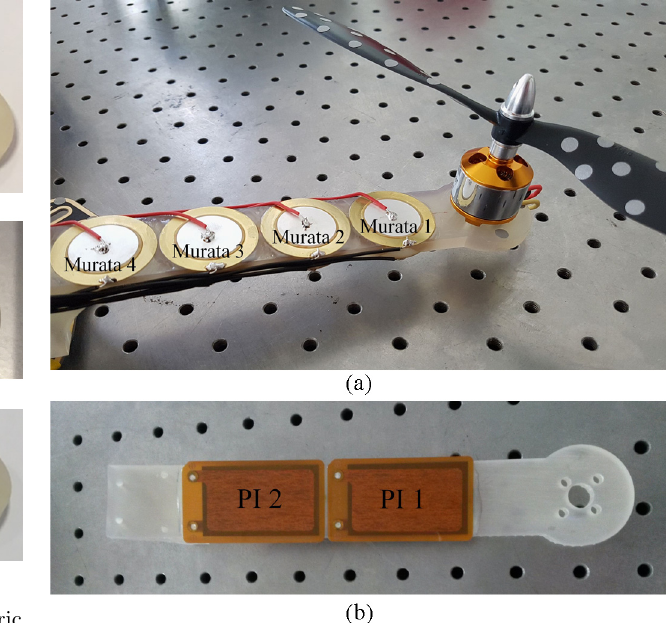
Fig. 12. Integration of commercial piezoelectric structures: (a) Murata buzzers, upper side of the arm, (b) PI DuraAct 876.A15 patches, upper part of the arm.